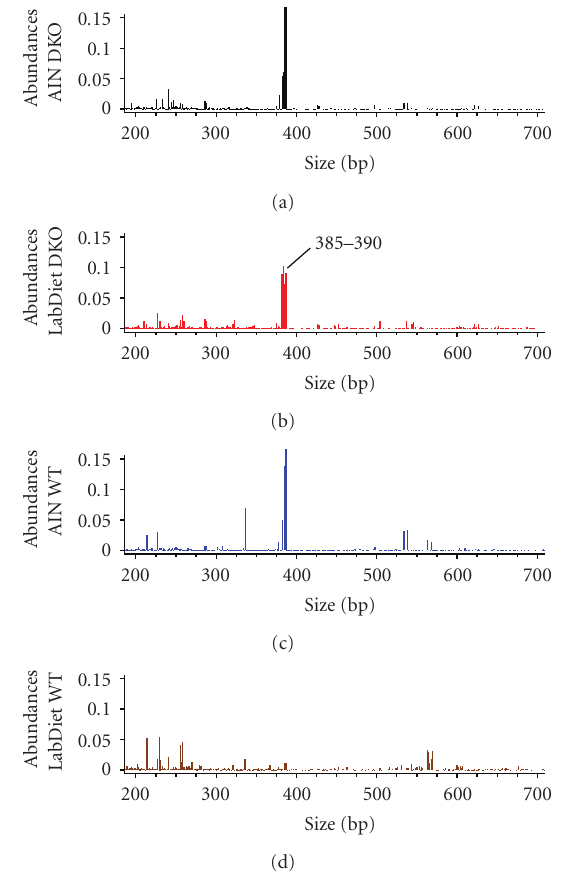
Figure 4: ARISA analysis of DNA from cecal contents of B6 on LabDiet or AIN diet. DNA amplified using primers corresponding to 16S and 23S ribosomal genes and oriented to contain the ribosomal intergenic spacer regions was resolved with a capillary DNA analyzer. The x -axis shows the size of the DNA peak, and y - axis shows the relative intensity of each peak. Each panel represents the average result of 6